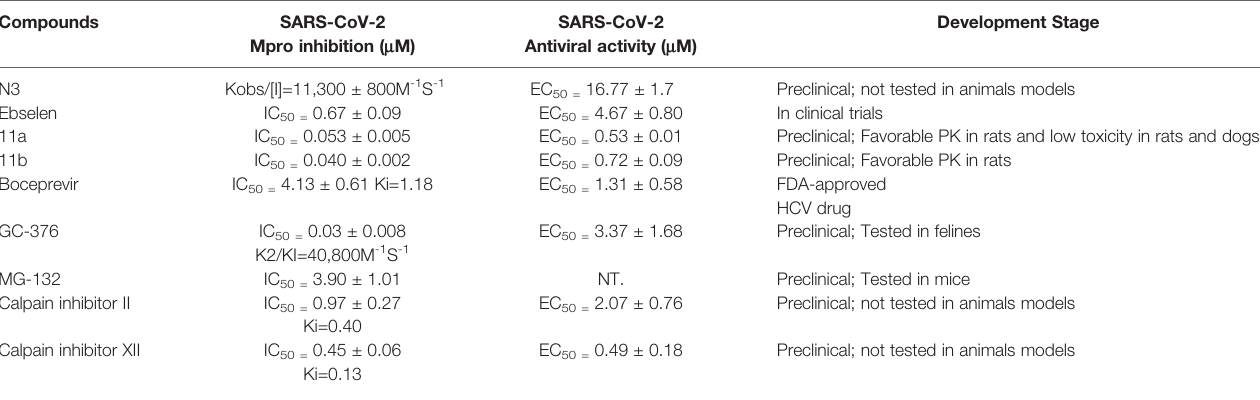
TABLE 2 | The summary of recently reported Mpro